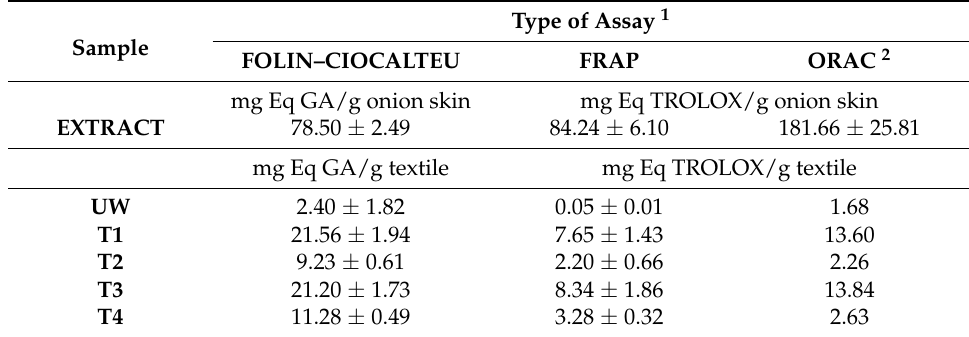
Table 3. Summary of the measured Folin–Ciocalteu, FRAP, and ORAC values of the onion extract and